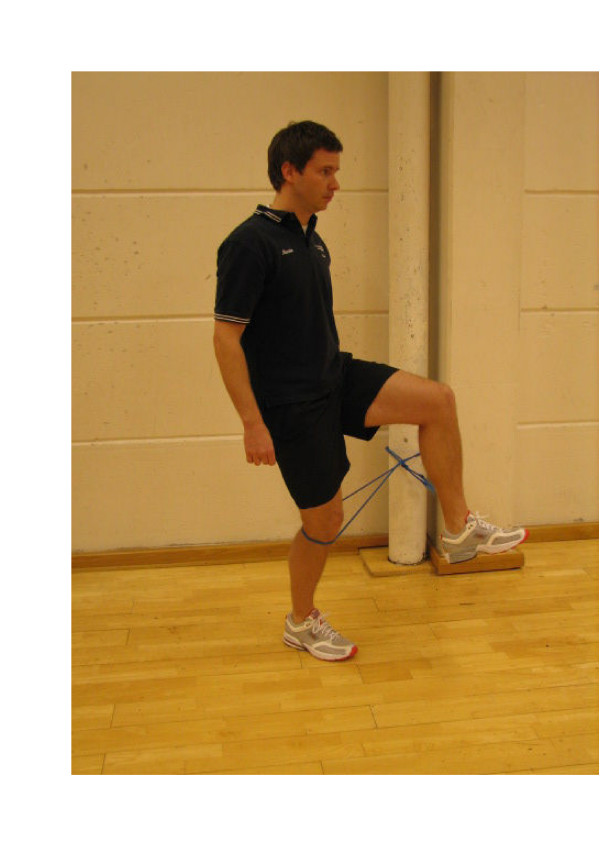
Knee control of the weight bearing leg with rubber band resistance.